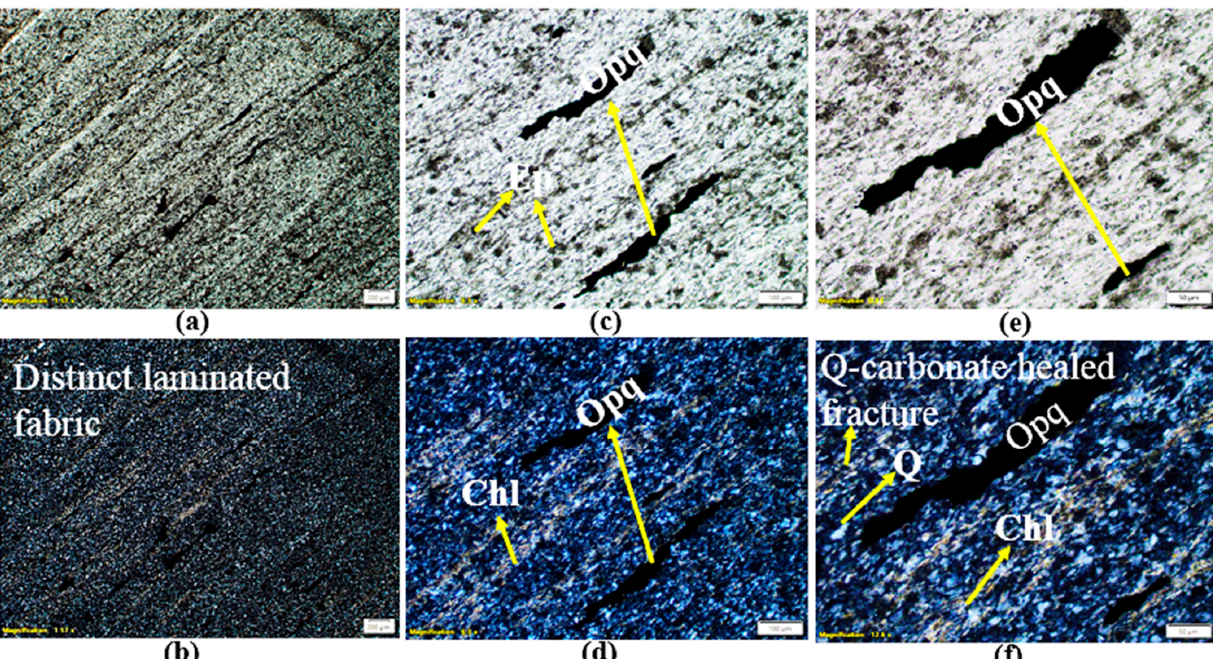
Figure 8. Results of petrographic analysis for microschist sample at room temperature (S1; 22 °C); images ( a – f ) were taken at different magnifications ( a , b : 1.57×; c , d : 6.3×; e , f : 12.6×) to reveal rock texture, mineral composition, and alteration in microschist (metasiltstone). Image ( a ) (PPL: plane polarized light) and image ( b ) (CPL: cross-polarized light) display fine- grained laminated texture in metasiltstone (microschist). Image ( c ) (PPL) and ( e ) (PPL) show the opaque scattered epidote. Image ( d ) (PPL) and ( f ) (CPL) display chlorite-rich bands intercalated within quartz-rich bands. Opaque (Opq) grains (dark) that are aligned, stretched, and elongated parallel to foliation plane were noted. The rock is extremely fine-grained, laminated and consists predominantly of (1) quartz (Q) (gray in CPL), where quartz grains are commonly aligned parallel to foliation plane, (2) chlorite (Chl; pale green), which is platy-to-flaky in nature, and the alignment of which marks the foliation plane, (3) epidote (Ep), which occurs in microcrystalline, anhedral granular aggregates in scattered-to-dense dis- seminations, which locally show subalignment in the plane of deformation, and (4) opaque grains (Opq; dark).